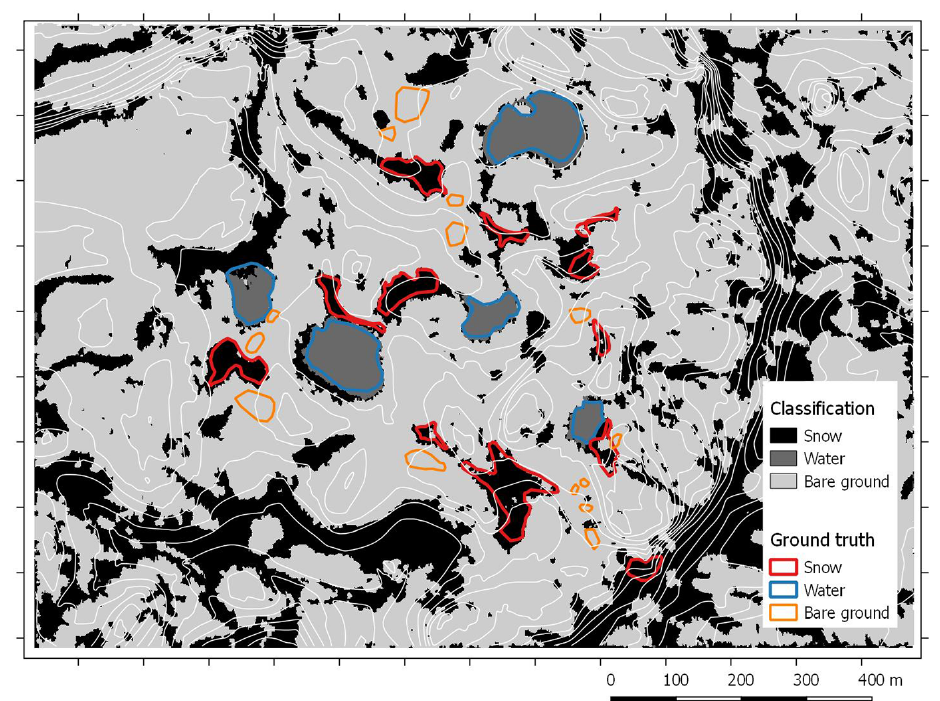
Figure 16. Distribution of wet snow in the Meseta Norte using an object-oriented classification with SVM (support vector